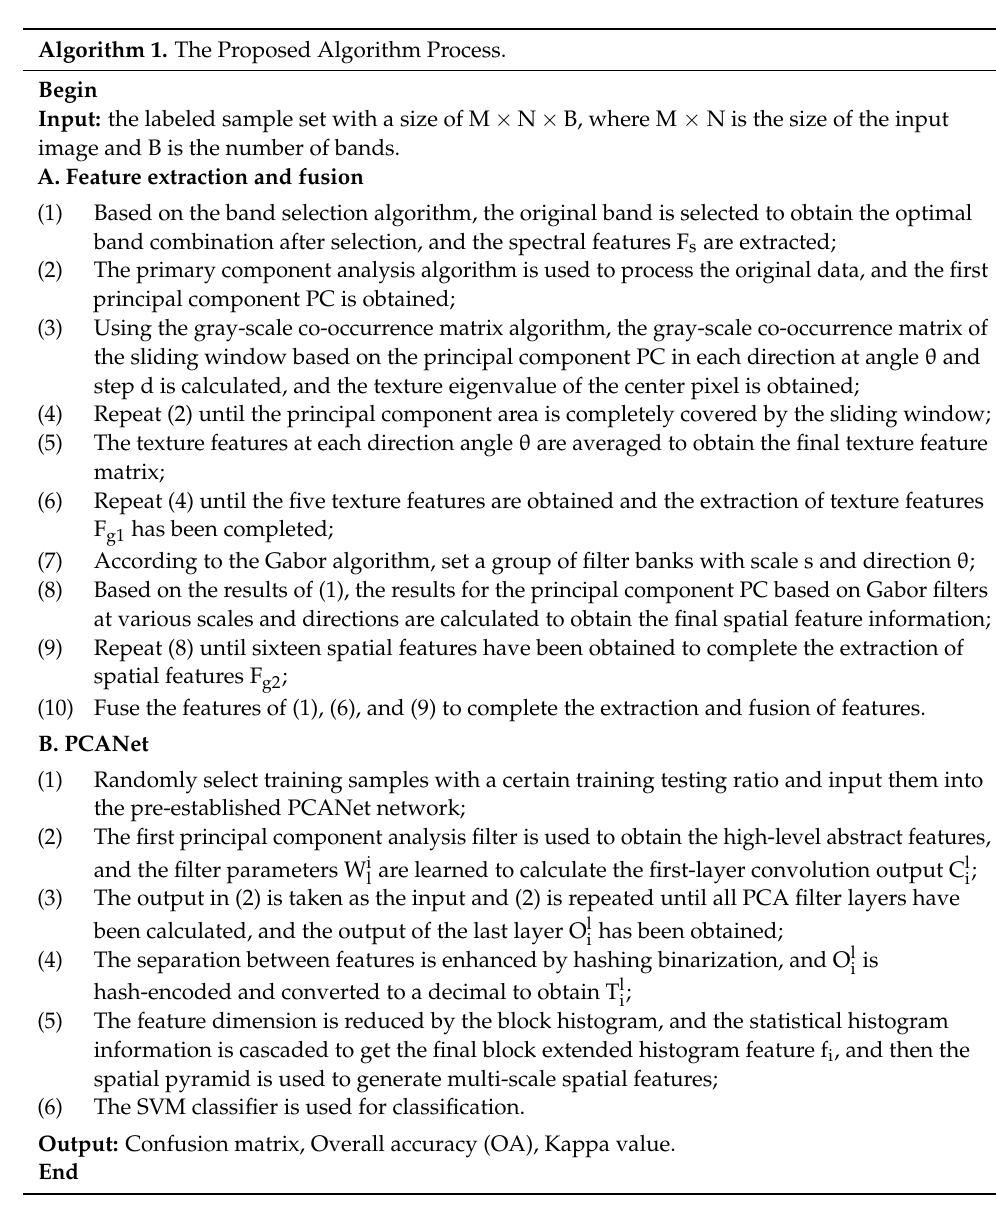
Algorithm 1. The Proposed Algorithm